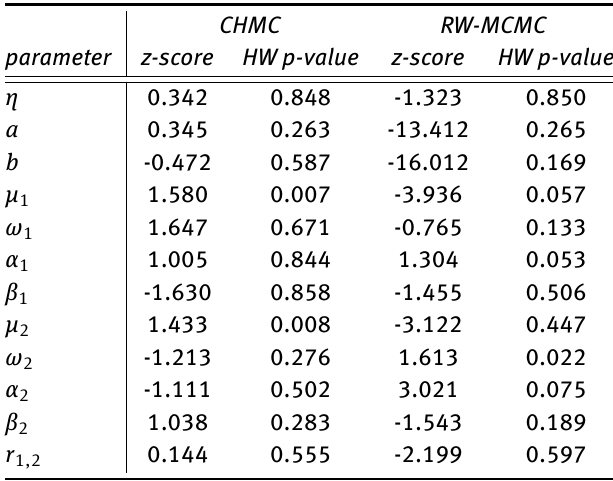
Table 3: Geweke z-score and Heidelberger and Welch (HW) diagnostics